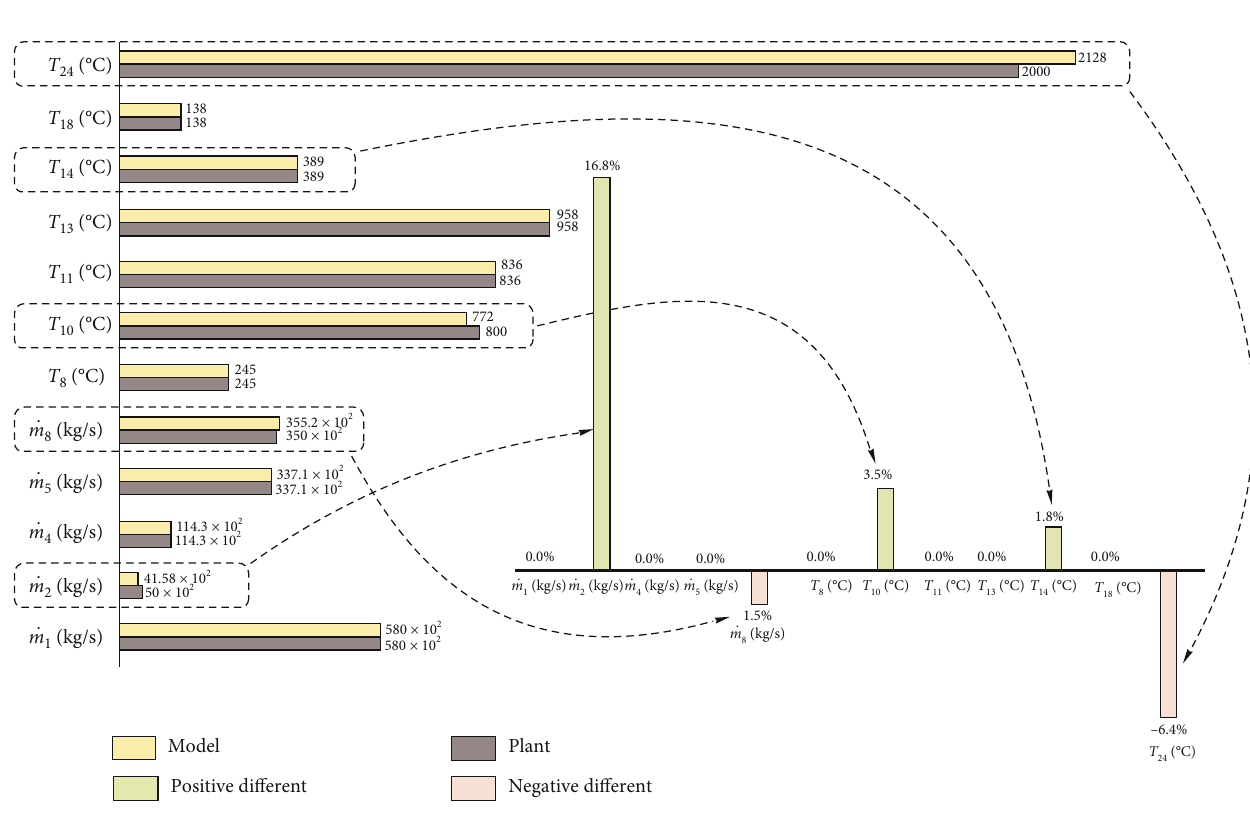
Figure 4: Validation of results obtained by simulation of RKS in Aspen Plus